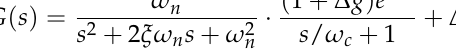
U represents 1 o U represents the out- o